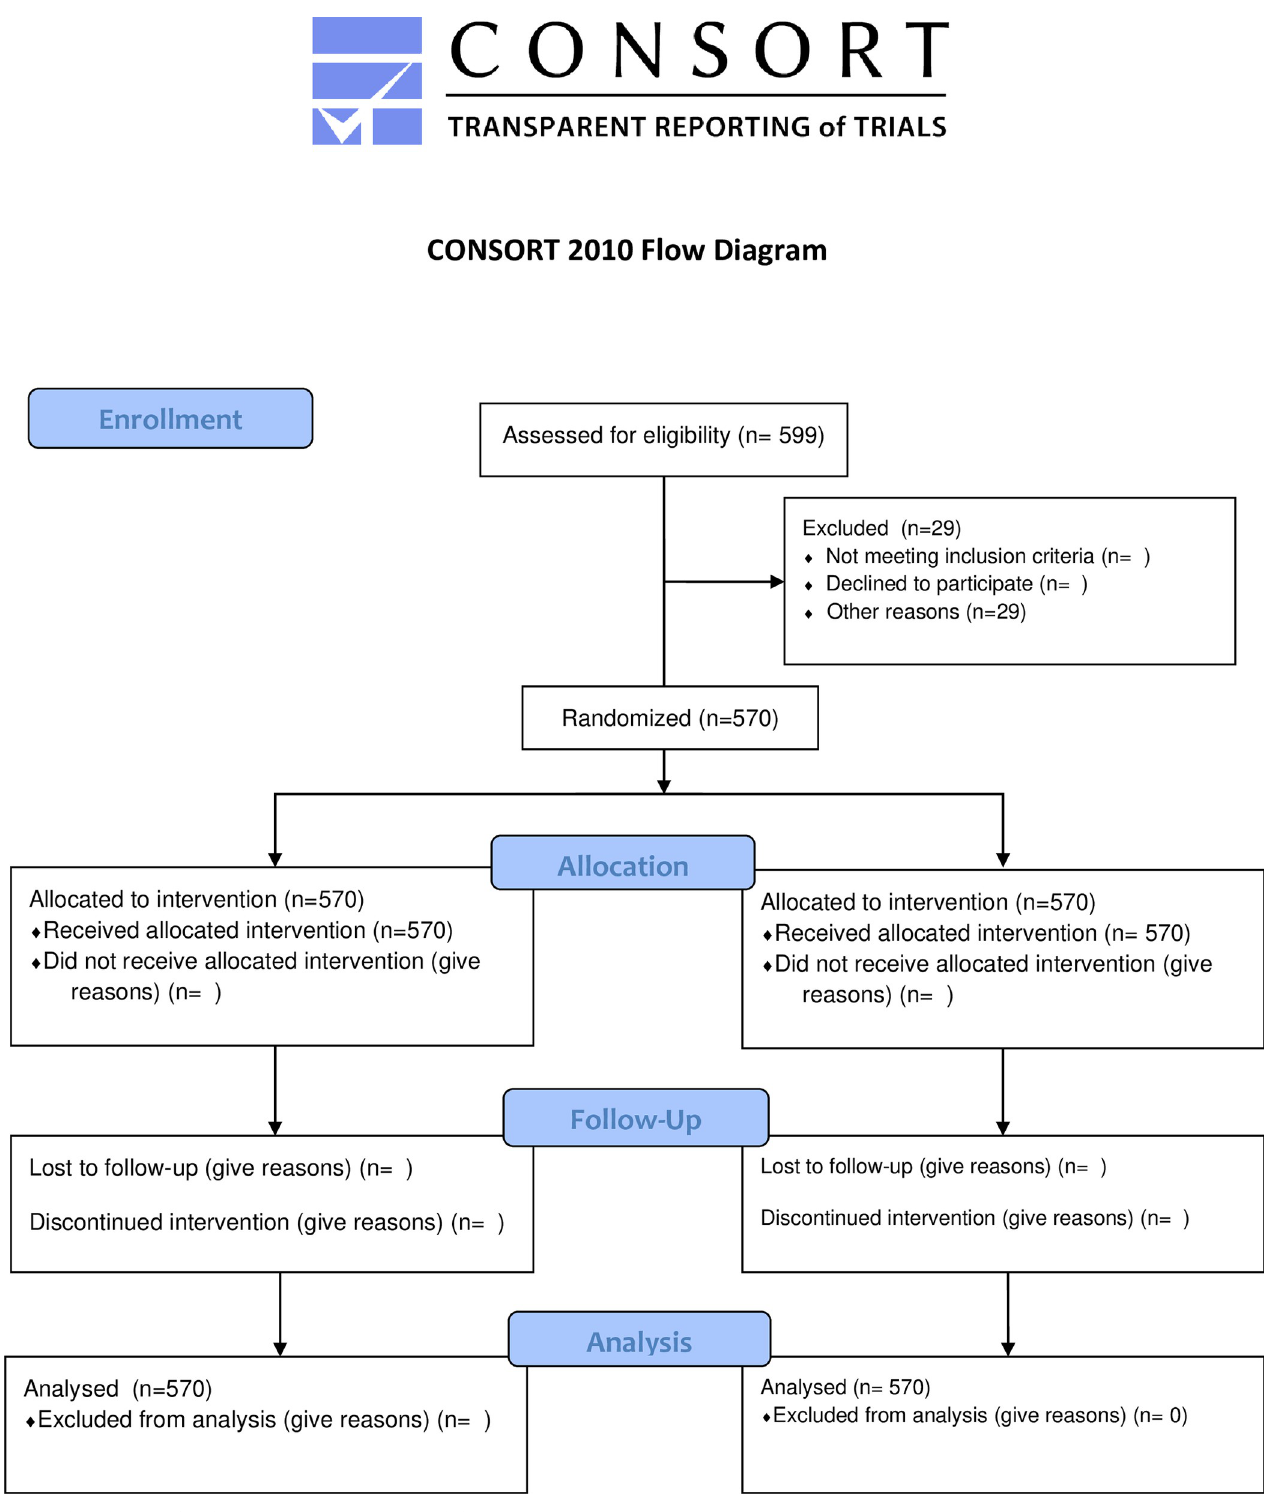
Fig 1. Flow diagram for the BAT SARS-CoV-2 test validation.